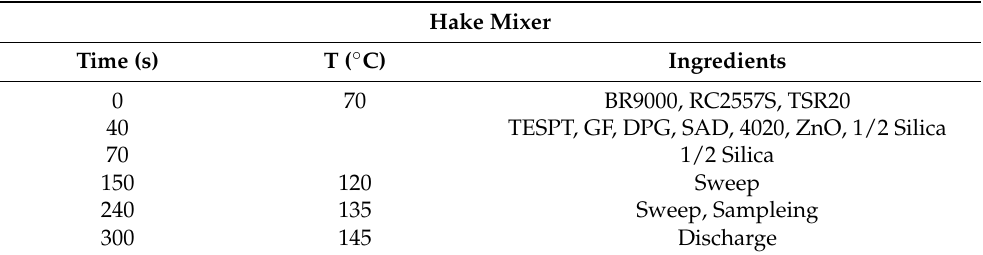
Table 3. Mechanical blending process.